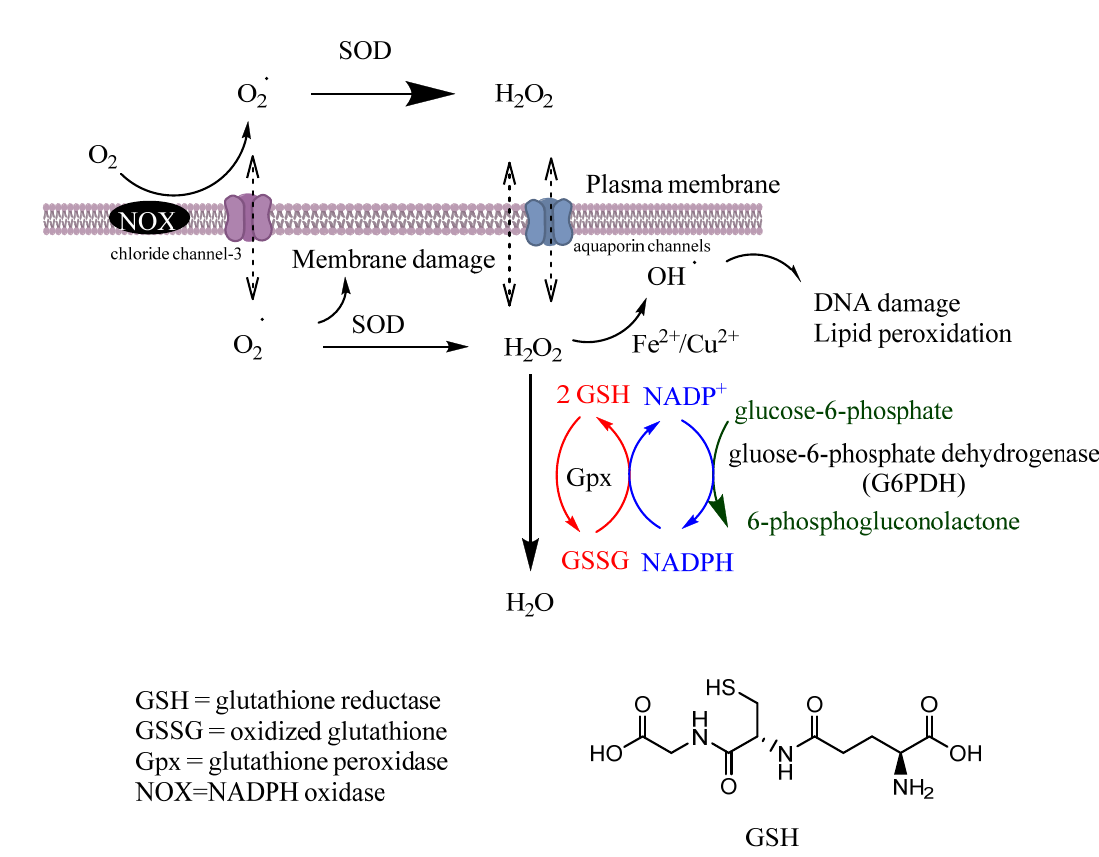
Figure 2. Scavenging of ROS. Coordination between various intracellular antioxidant enzymes (SOD, CAT, GR, Gpx) is a crucial mechanism for controlling ROS homeostasis and signaling. Secondary enzymes Gpx and G6PDH sustain the activity of primary enzymes by regenerating NADPH.